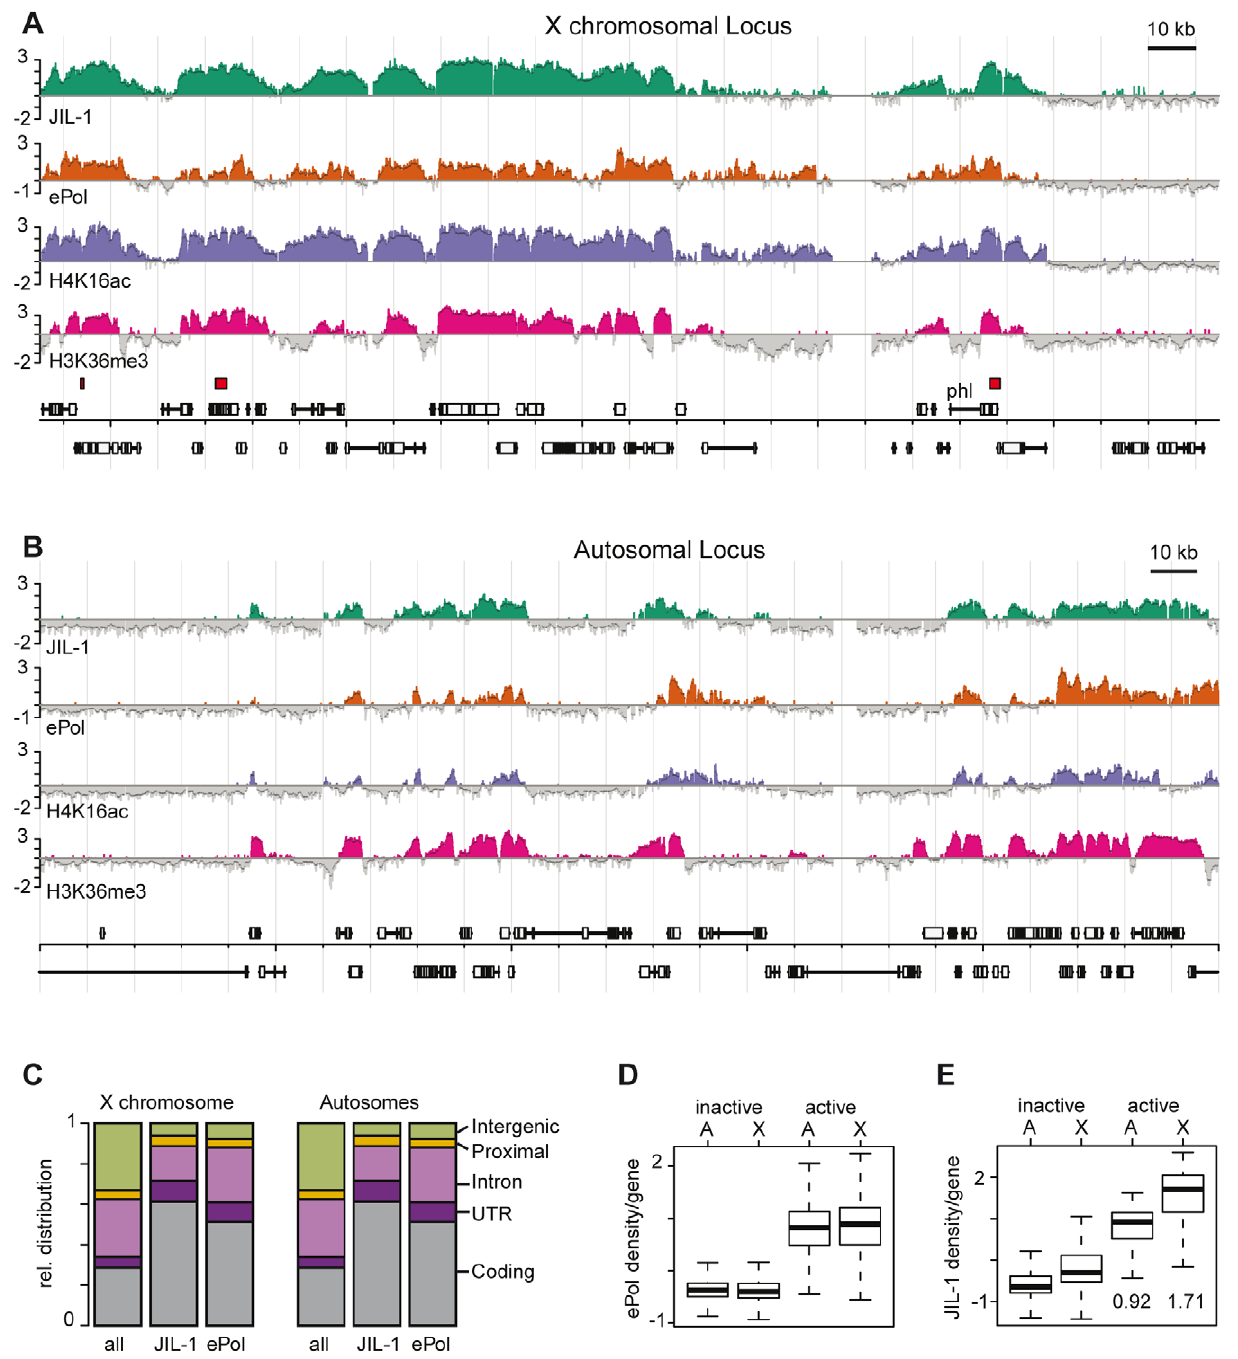
Figure 1. JIL-1 is a mark for gene activity and for dosage compensation in SL2 cells. High resolution ChIP on chip profiles of JIL-1, ePol, H4K16ac and H3K36me3 [30]. The data is represented as average log2 signal ratio of IP over input. Bars are coloured when the signal is above zero. The dark grey line toping each profile represents the mean signal within a 500 bp window centred on the probe. High affinity sites (HAS) for the DCC according to [29] are depicted as red boxes above the gene annotations. A representative 250 kb portion has been selected (A) for the X chromosome and (B) for chromosome 3R. (C) Fractional distribution of oligonucleotides according to genomic features is shown for all probes on the array (n=384680) and compared to the ones within JIL-1 (n=112954) and ePol (n=125303) binding regions as determined by hidden markov modelling. (D) The density per gene was defined as the average ratio (IP/input) of probes within a gene. The densities of ePol on autosomal genes (labelled A) and X-linked genes (labelled X) in a box plot representation. Activity status was determined by microarray expression profiling. (E) JIL-1 densities on the same sets of genes as in D, the median values for active autosomal and X-linked genes are given. The boxplot representation in all figures define 25th to 75th percentiles (boxes), 50th percentile (lines in boxes), and ranges (whiskers, 1.5 times the interquartile range extended from both ends of the box). Outliers were removed from the analysis.